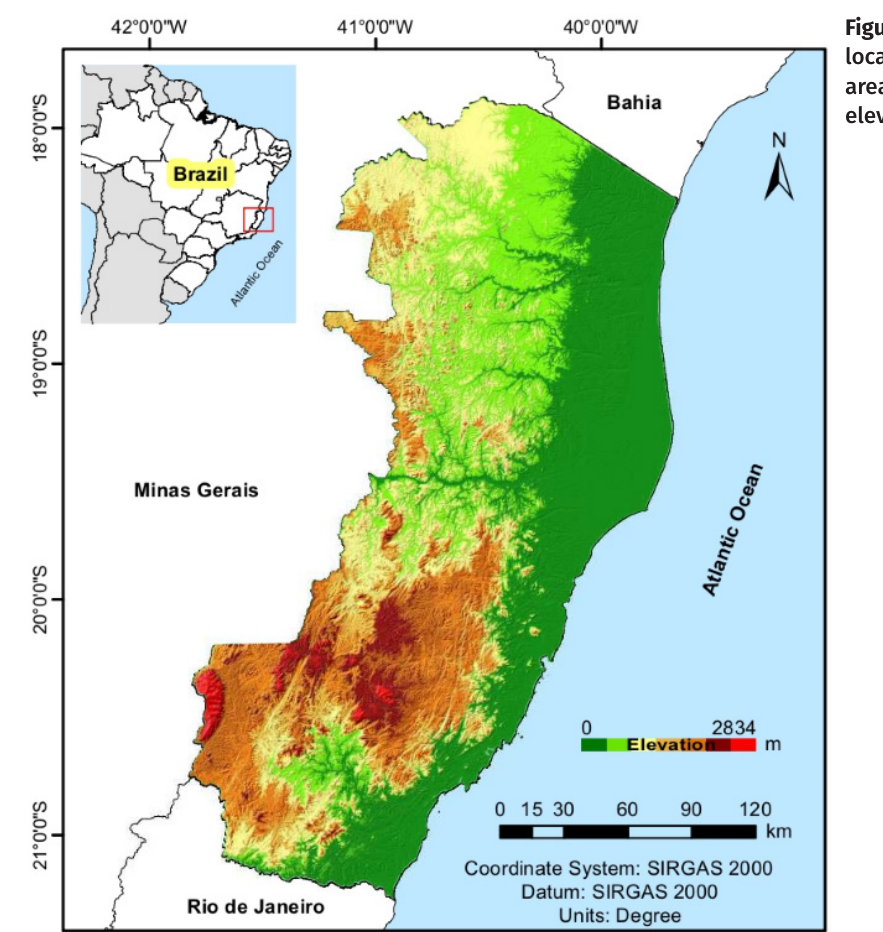
Figure 1. Geographical location of the study area with digital elevation